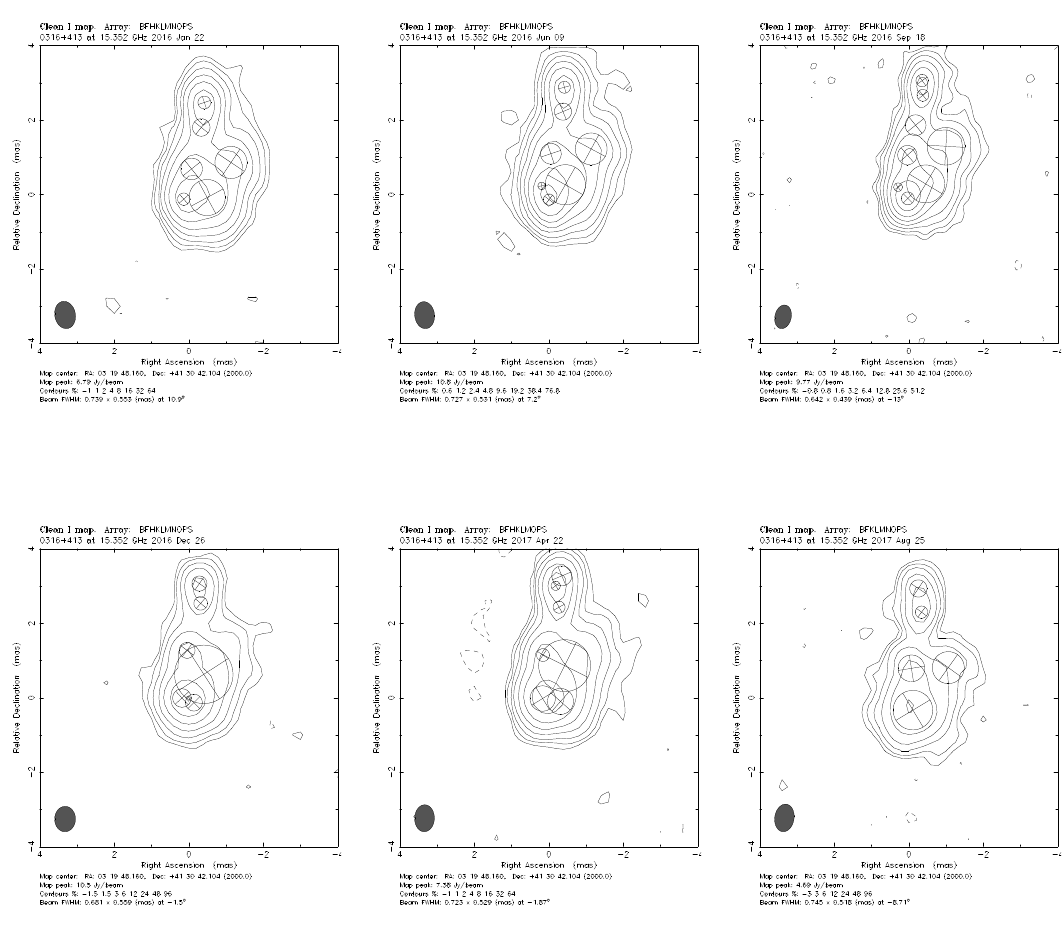
Figure A5. Same as Figures A1–A4 for epochs: January 2016—August